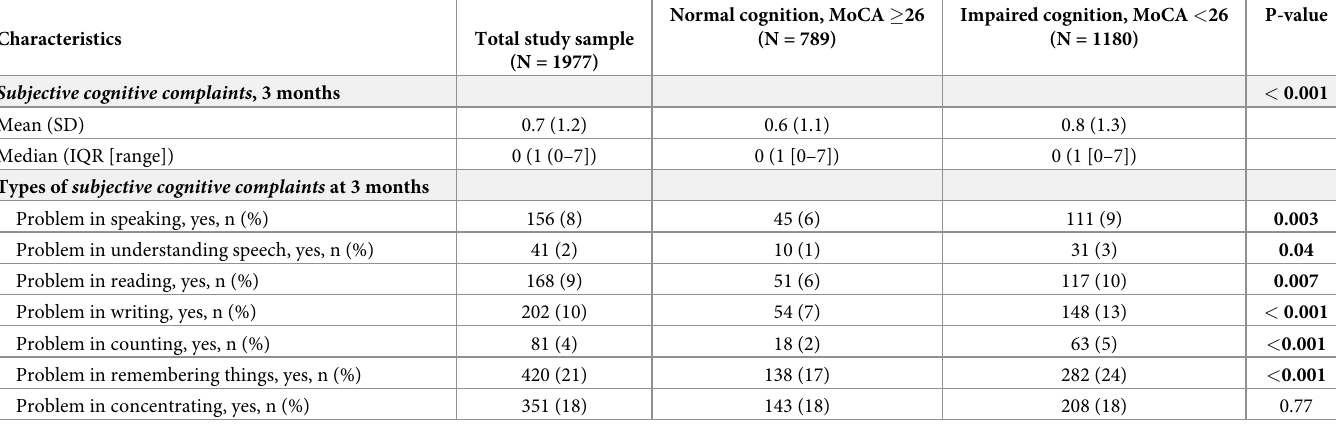
Table 3. S ubjective cognitive complaints 3 months after stroke in the total sample as well as stratified based on cognitive function at baseline.